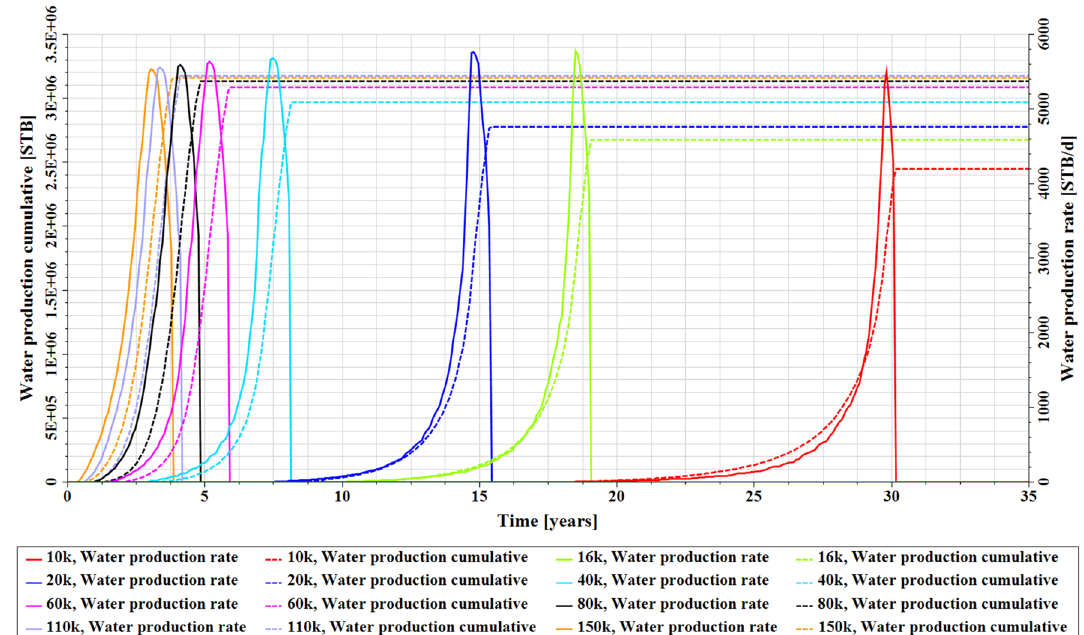
Fig. 20 Water productions vs. time for different gas production rates